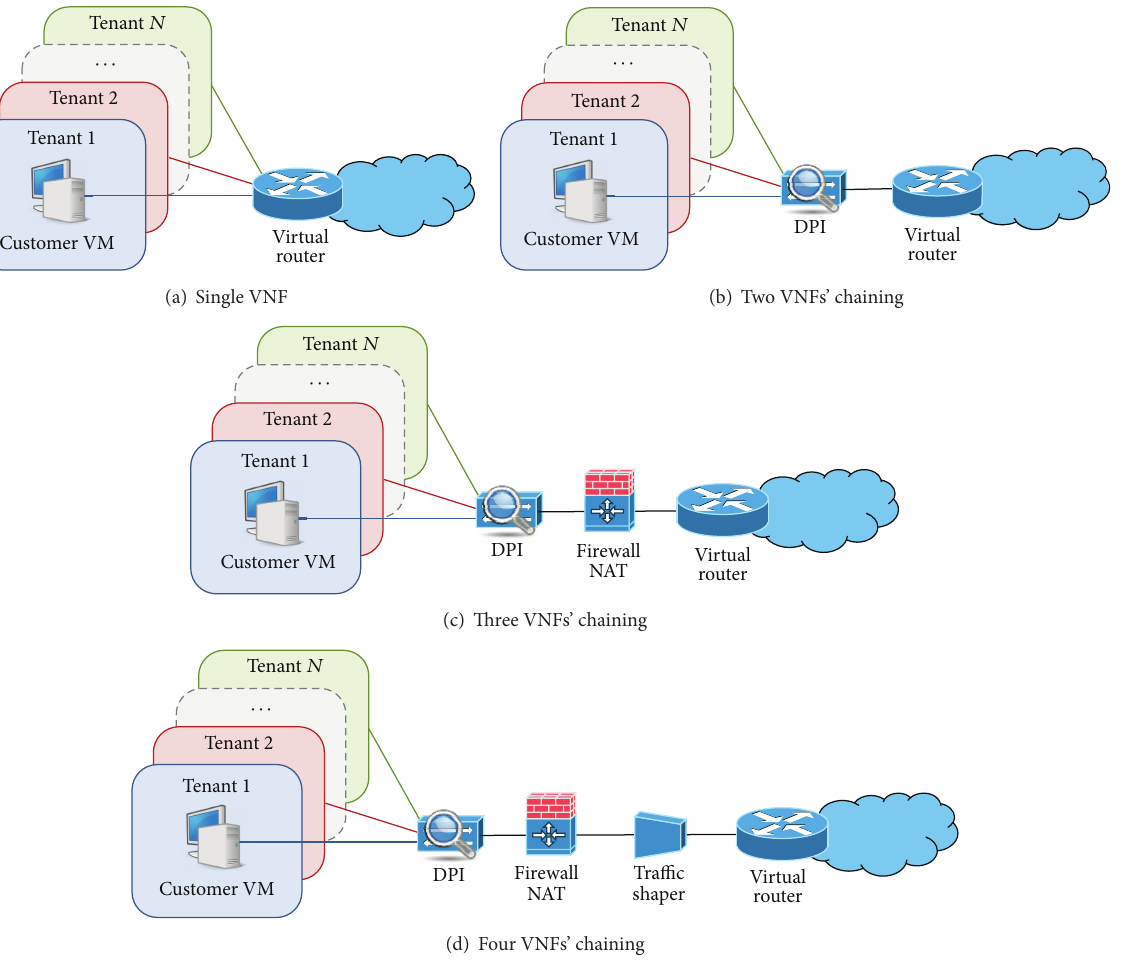
Figure 7: Multitenant NFV scenario with shared network functions tested on the OpenStack